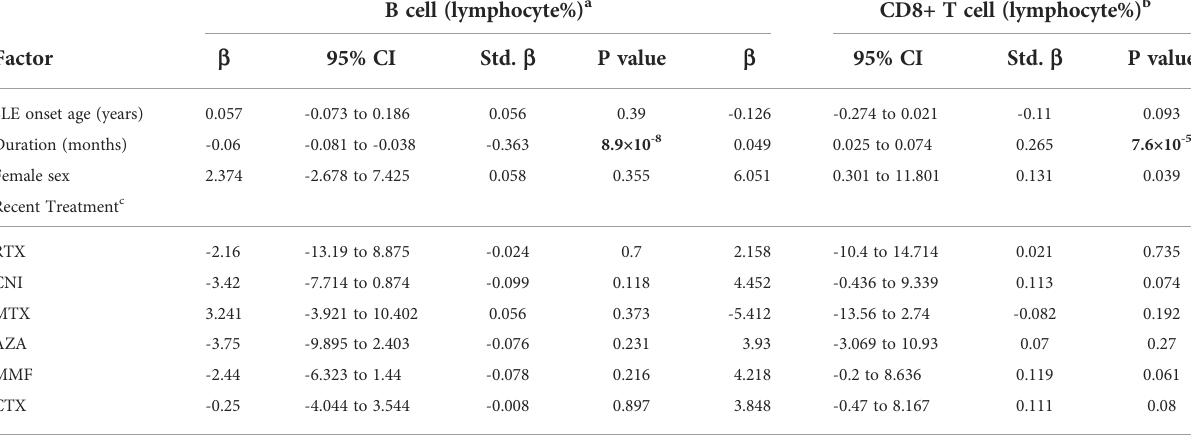
TABLE 3 Multivariate analysis of associators for peripheral B cell and CD8+ T cell proportion in active SLE cases (n=222, Model 1).